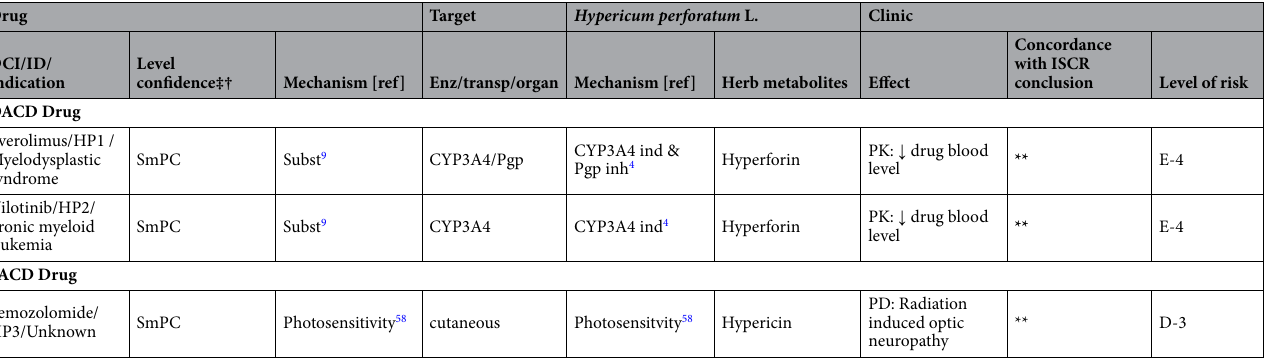
Table 4. Hypericum perforatum L . - ACD interactions among selected ICSRs. OACD: Oral Anti-Cancer Drug; PACD: Parenteral Anti-Cancer Drug; PD: pharmacodynamic; PK: pharmacokinetic; Pgp: P-glycoprotein; CYP3A4: Cytochrome P 450 isoform3A4; Subst: Substrate; Inh: Inhibitor; Ind: Inducer; n.k.: not known; Enz: enzyme; Transp: Transporter; ‡SmPC: Summary of product Characteristics. "Scoring" for the significance of the indicators "*", "**".